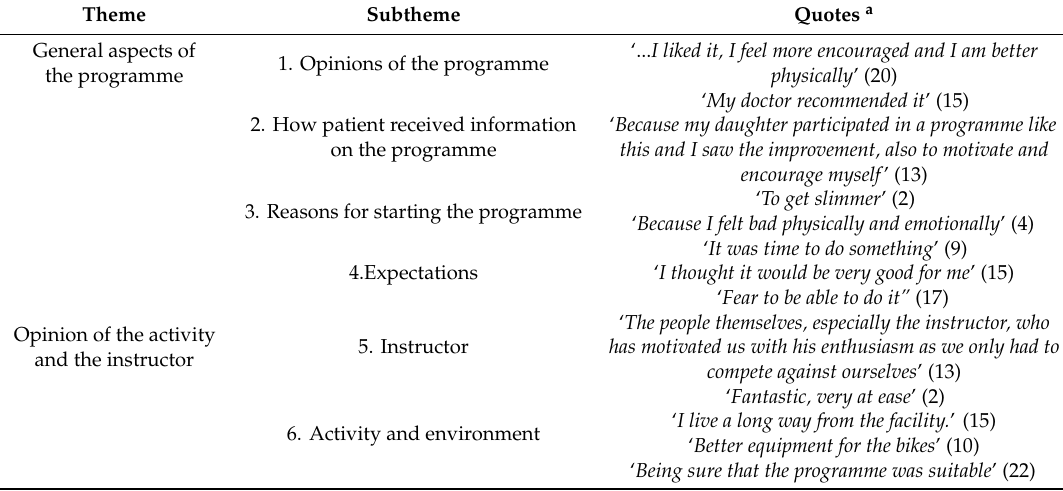
Table 2. Summary of findings.